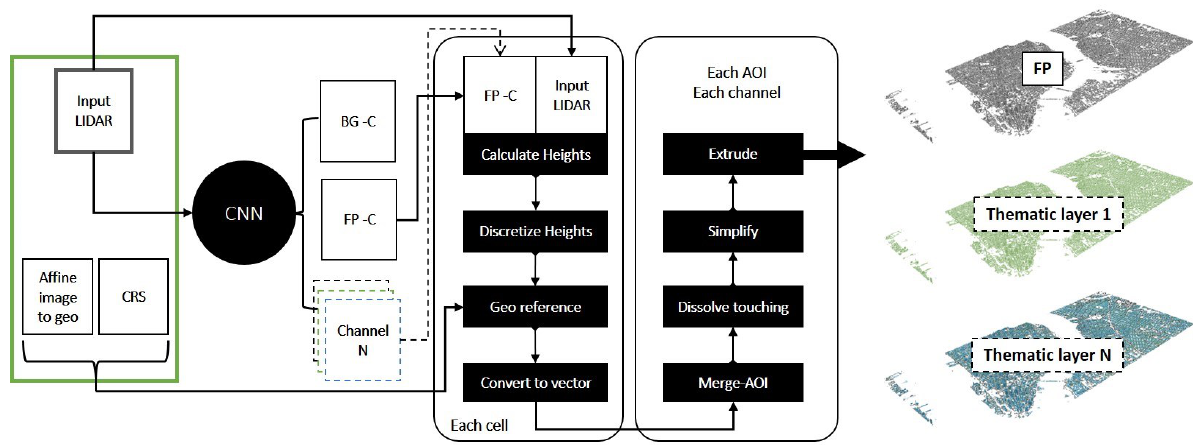
Figure 2. Proposed pipeline. BG Background channel. FP Footprint channel. CNN Convolutional Neural Network. The word vector refers to a specific data representation that is used in the context of geographical information systems